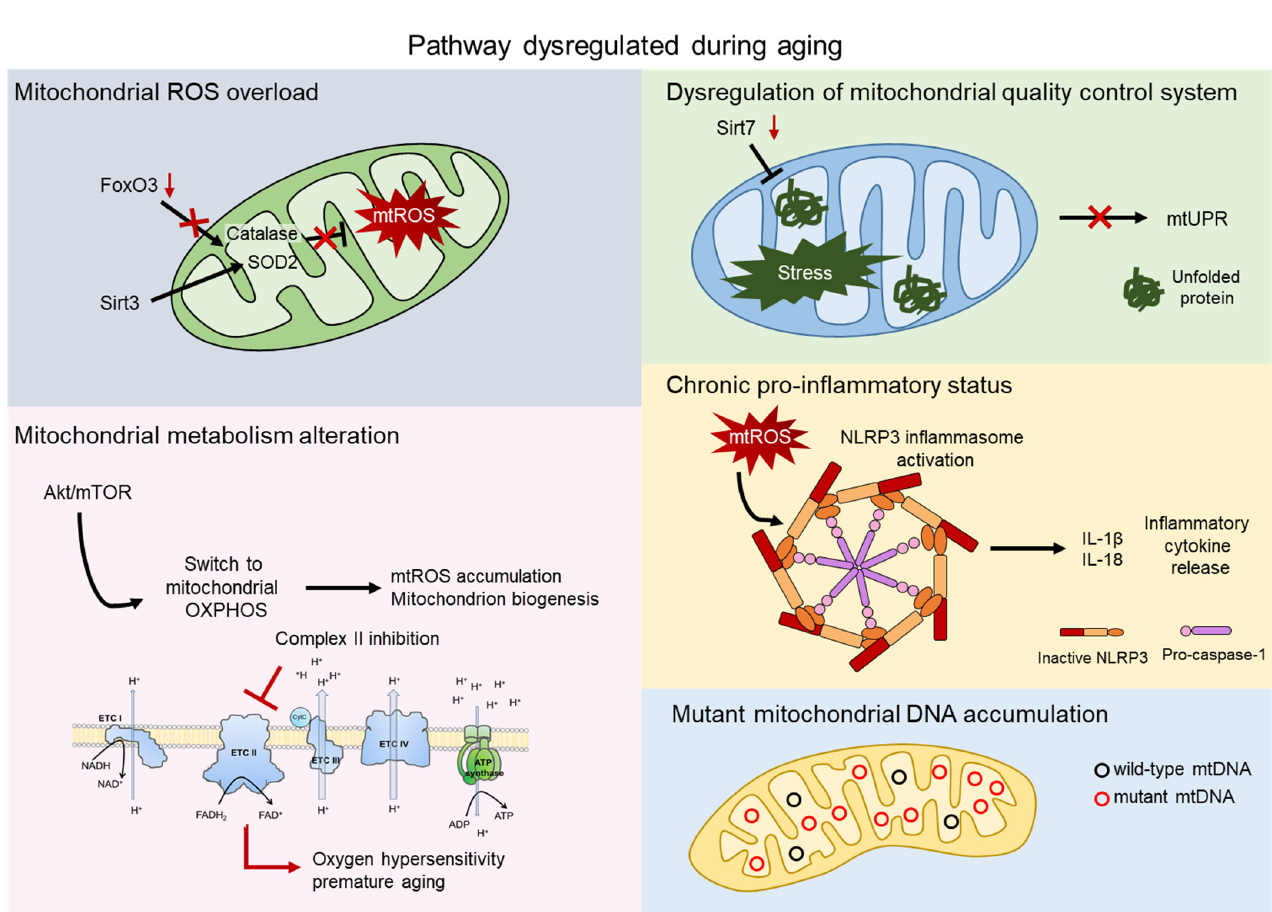
Figure 2. Mitochondrial contribution to aging. Aging process shows dysregulation of several pathway involving the direct contribution of mitochondria. Mitochondrial reactive oxygen species (mtROS) accumulate after the impairment of the major antioxidant defense systems, consist of Superoxide dismutase 2 (SOD2) and Catalase, caused by the aged-related loss of FOXO3 and SIRT3 (grey). AKT/mTOR signaling is a key regulator of mitochondrial metabolism and, upon aging, its imbalance causes mtROS accumulation, mitochondrial biogenesis, and an altered metabolism. Inhibition of complex II of the electron transport chain (ETC) leads to oxygen hypersensitivity and premature aging of HSCs (pink). The mitochondrial unfolded protein response system (mtUPR) is affected by the aged-related loss of SIRT7 , leading to accumulation of unfolded protein and mitochondrial stress (green). Accumulation of mtROS activates the NOD-, LRR-, and pyrin domain-containing 3 (NLRP3) inflammasome, which triggers the release of inflammatory cytokines, such as IL-1 β and IL-18 (orange). Mitochondrial dysfunctions include accumulation of mtDNA mutations in aged HSCs (blue).